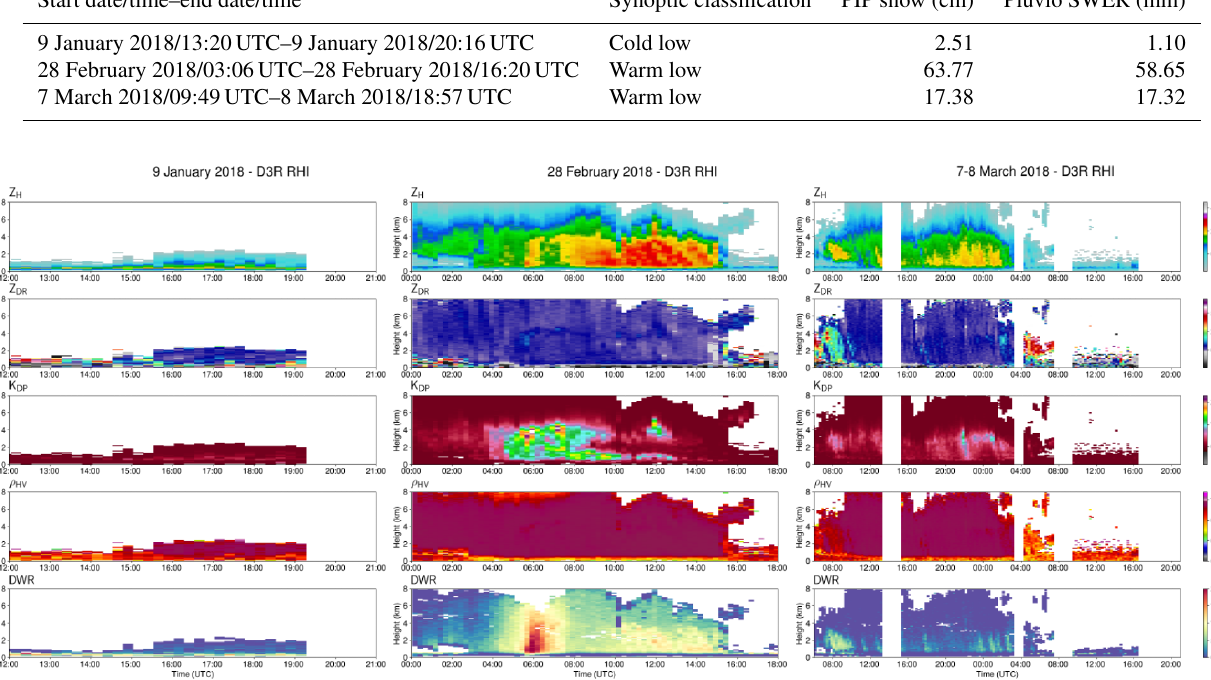
Figure 1. Time–height plots of vertical profiles of Z H (first row), Z DR (second row), K dp (third row), ρ hv (fourth row), and DWR (fifth row) for the 9 January 2018 (left column), 28 February 2018 (middle column), and 7–8 March 2018 (right column)